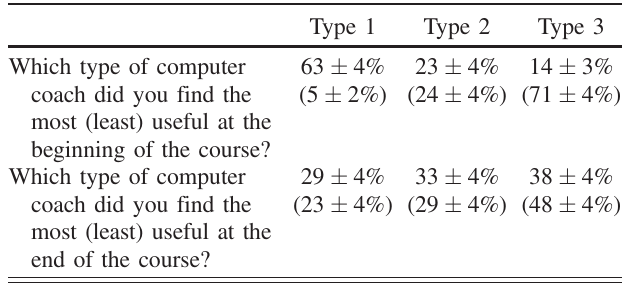
TABLE V. Fall 2011 student responses to a survey question asking them which type of coach they found to be the most or least useful at the beginning and end of the